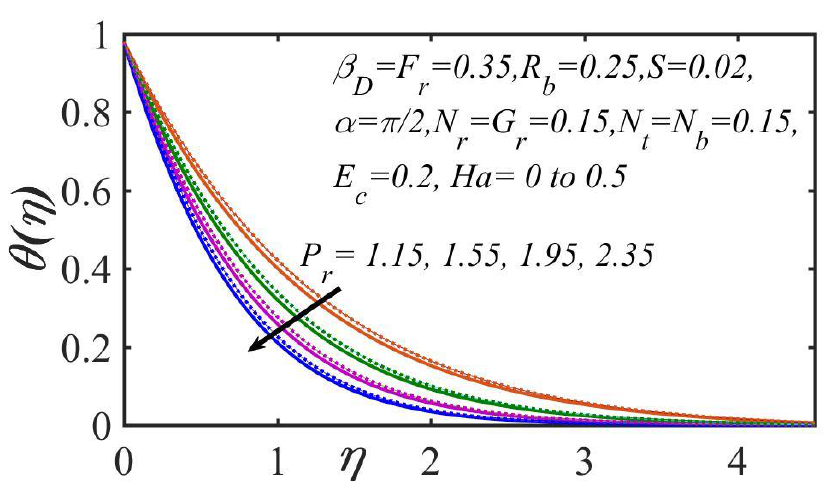
Figure 6. Impact of P r and Ha on temperature magnitudes. Solid curve: Ha = 0; dotted curve: Ha = 0.5 .